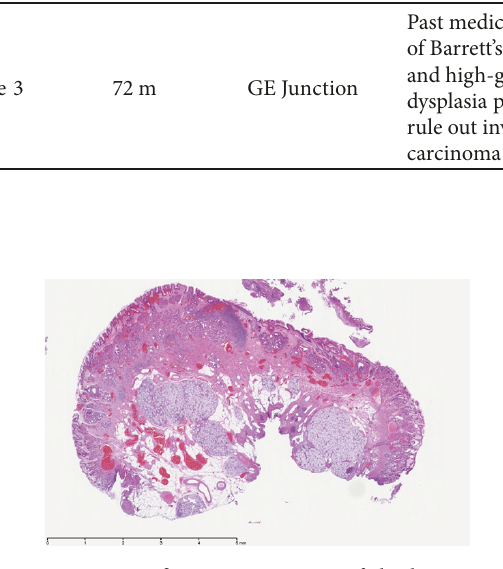
Figure 2: High-magnification appearance of the heterotopic sali- vary glands demonstrating prominent mucus glands with chronic